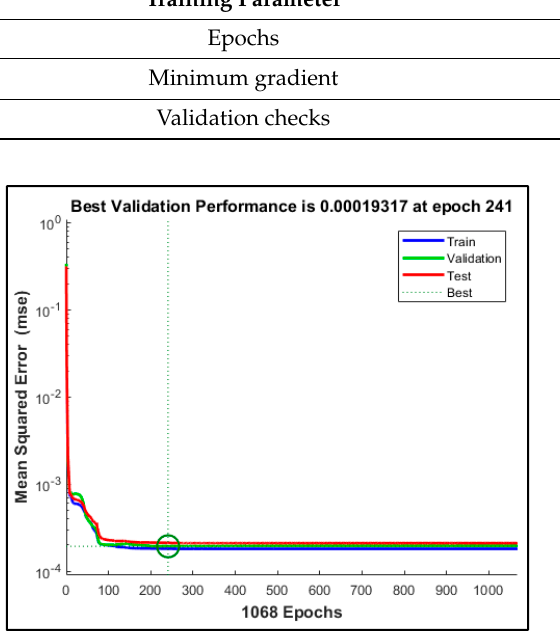
Table 8. ANN training parameters.